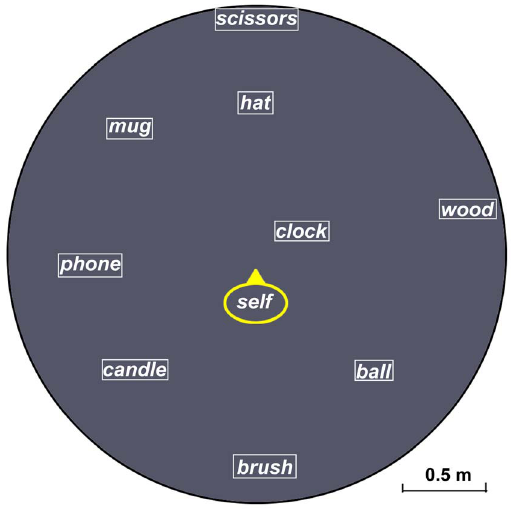
Figure 1. The map of the object array used in Experiment 1.